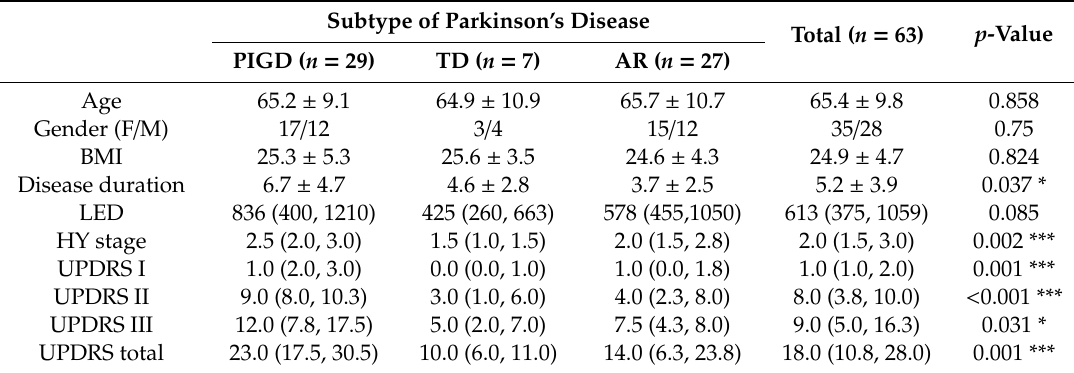
Table 1. Baseline characteristics of Parkinson’s